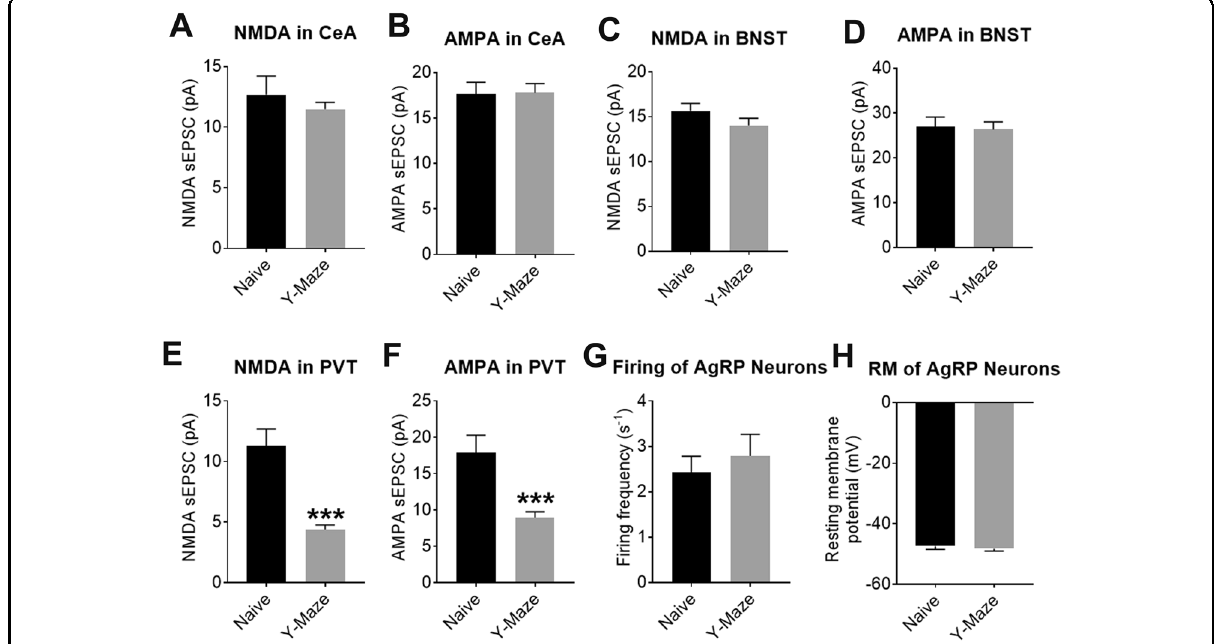
Fig. 5 Y-maze conditioning induced neural plasticity in AgRP-innervated PVT neurons. A , C , E NMDA sEPSC in the AgRP-innervated neurons in the CeA ( A ), BNST ( C ), and PVT ( E ) from naive mice or Y-maze-trained mice. B , D , F AMPA sEPSC in the AgRP-innervated neurons in the CeA ( B ), BNST ( D ), and PVT ( F ) from naive mice or Y-maze-trained mice. Data are mean ± SEM. n = 5 or 10 per group. *** P < 0.001 vs. naive group in two-tailed unpaired t tests. G , H Firing frequency ( G ) and resting membrane potential ( H ) of AgRP neurons from naive mice or Y-maze-trained mice. Data are mean ± SEM. n = 12 per group. Also see Fig.